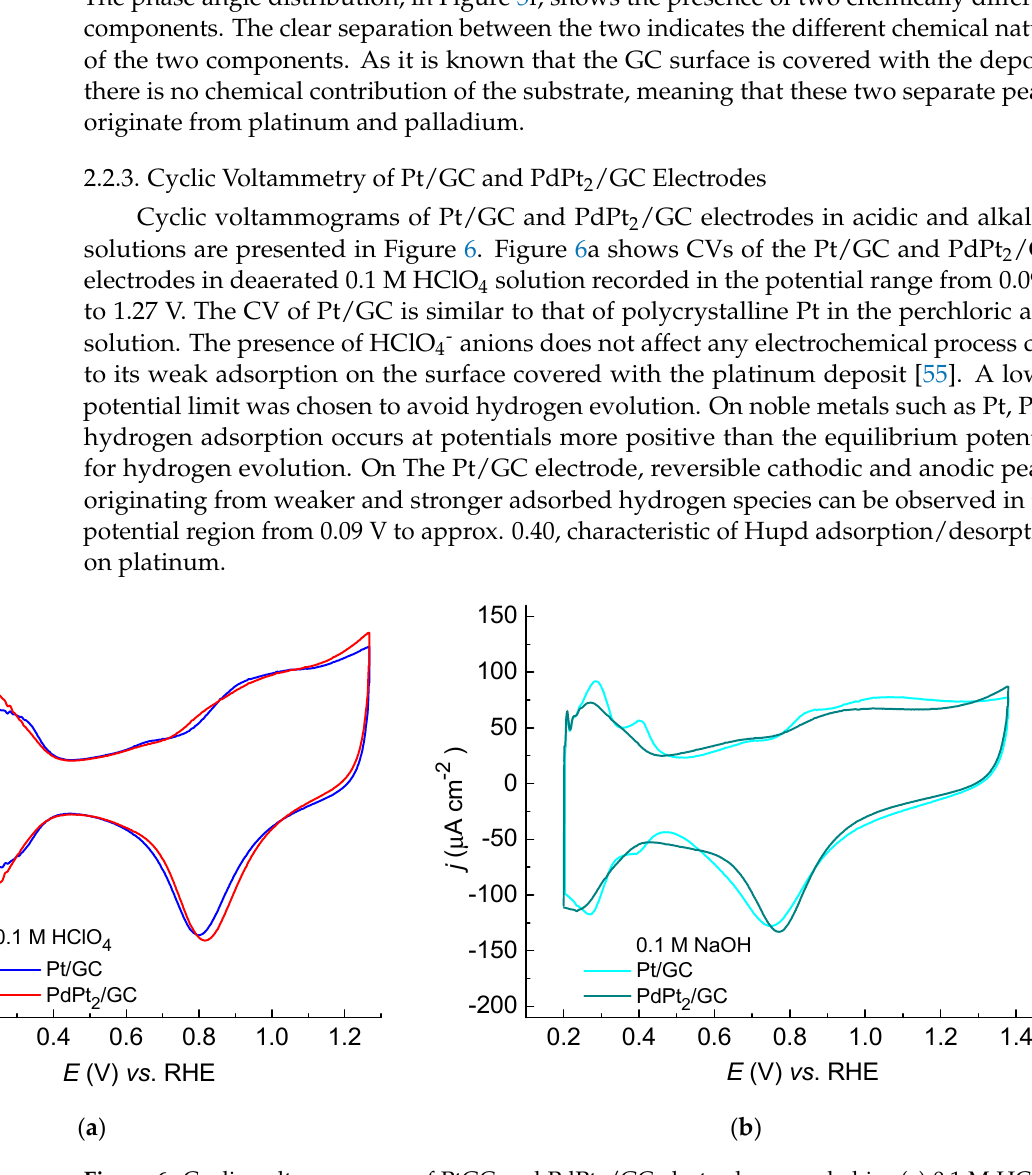
Figure 6. Cyclic voltammogrms of PtGC and PdPt 2 /GC electrodes recorded in: ( a ) 0.1 M HClO 4 so- lution; ( b ) 0.1 M NaOH solution. Scan rate 50 mV s − 1 . solution; ( b ) 0.1 M NaOH solution. Scan rate 50 mV s − 1